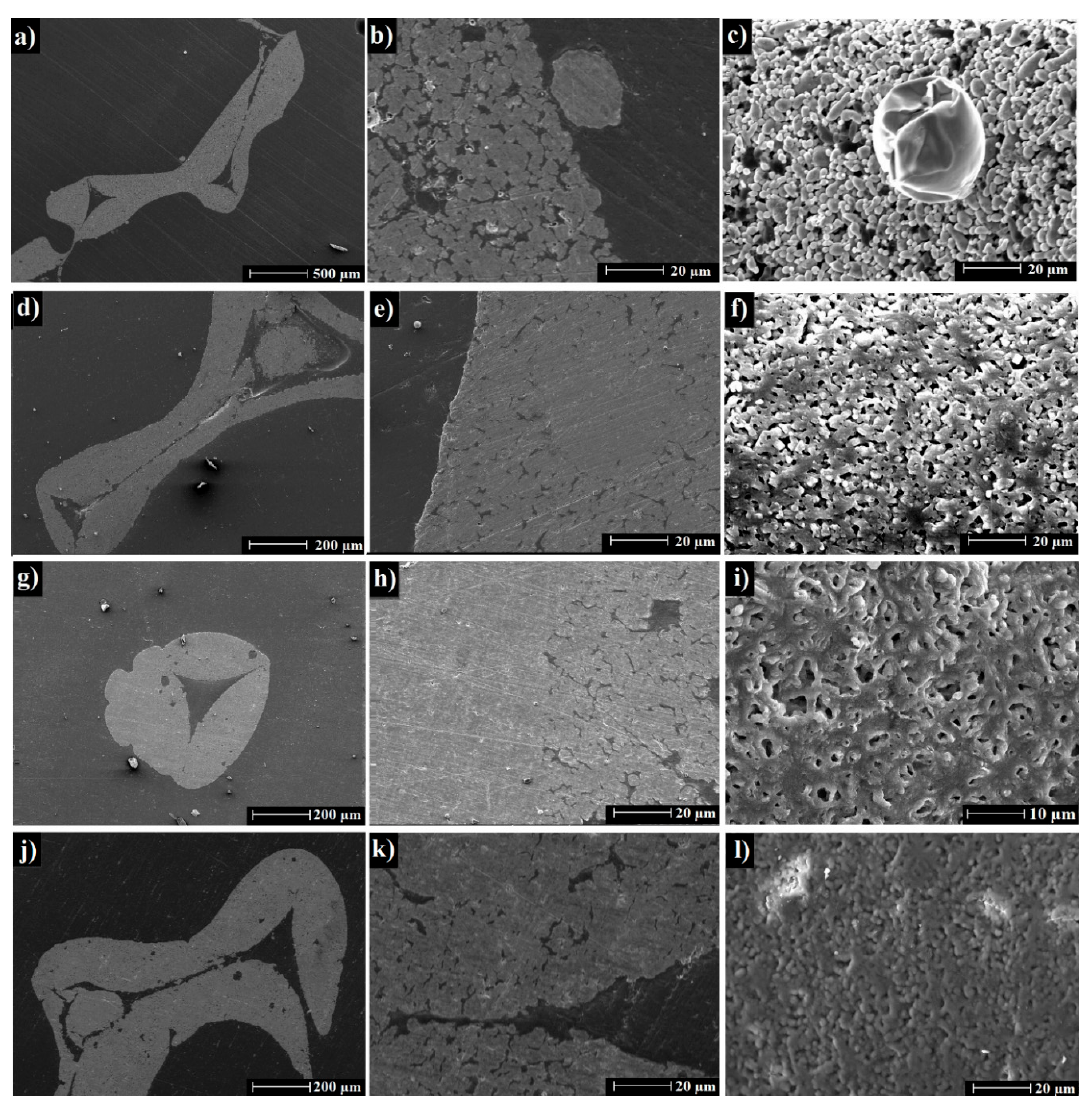
Figure 4. SEM images of aluminum foams thermally processed for 3 h at 750 ◦ C in air ( a – c ) and Ar at 750 ◦ C ( d – f ), 800 ◦ C ( g – i ), and 850 ◦ C ( j – l